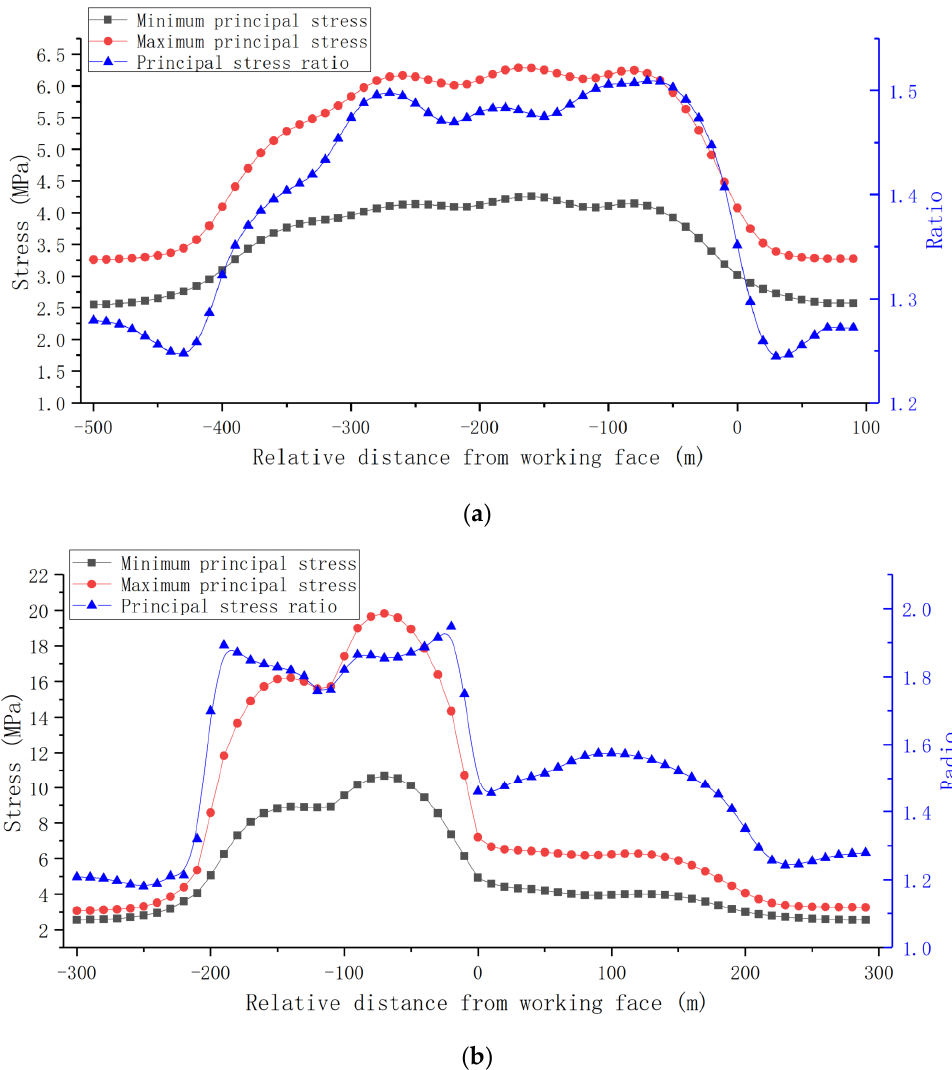
Figure 8. Relationship between distribution of principal stress and position of working face: ( a ) primary mining influence; ( b ) secondary mining influence.